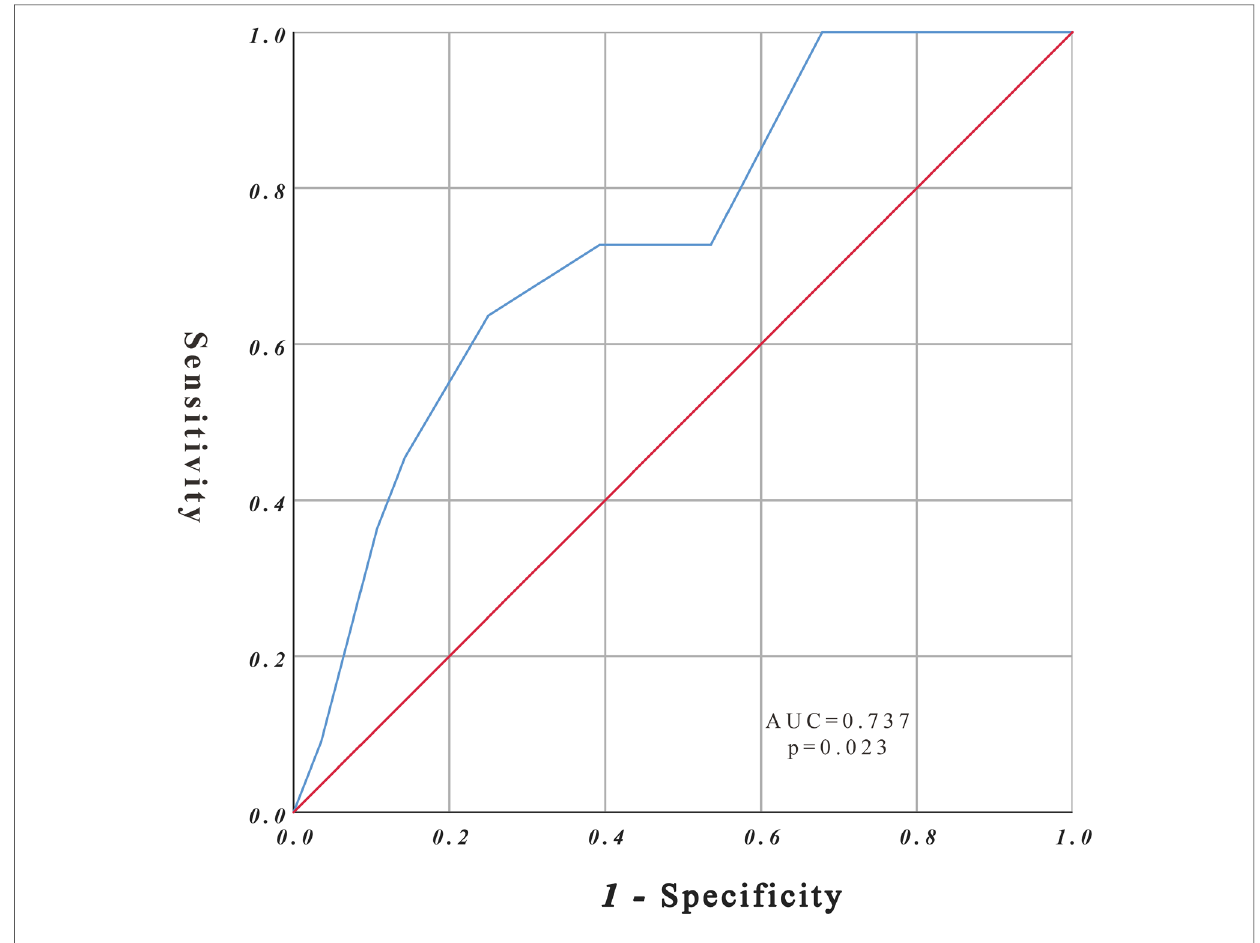
FIGURE 2 ROC curve analysis for survival